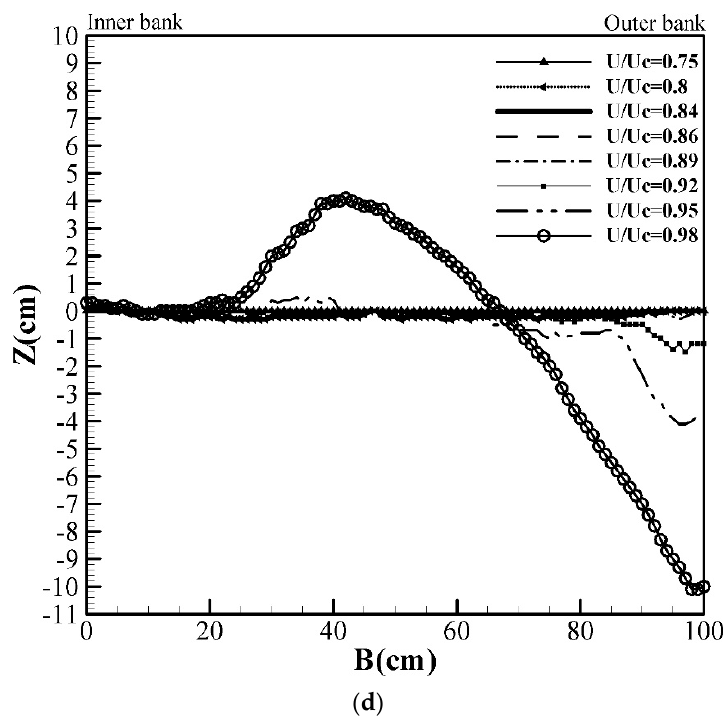
Figure 7. Instances of variations in the lateral bed profiles at ( a ) 225-, ( b ) 270-, ( c ) 315-, and ( d ) 360-degree angles of the downstream bend.